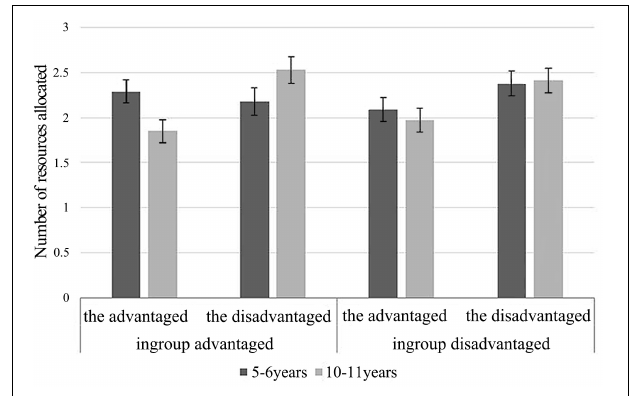
FIGURE 1 | Number of resources children allocated between groups in experiment